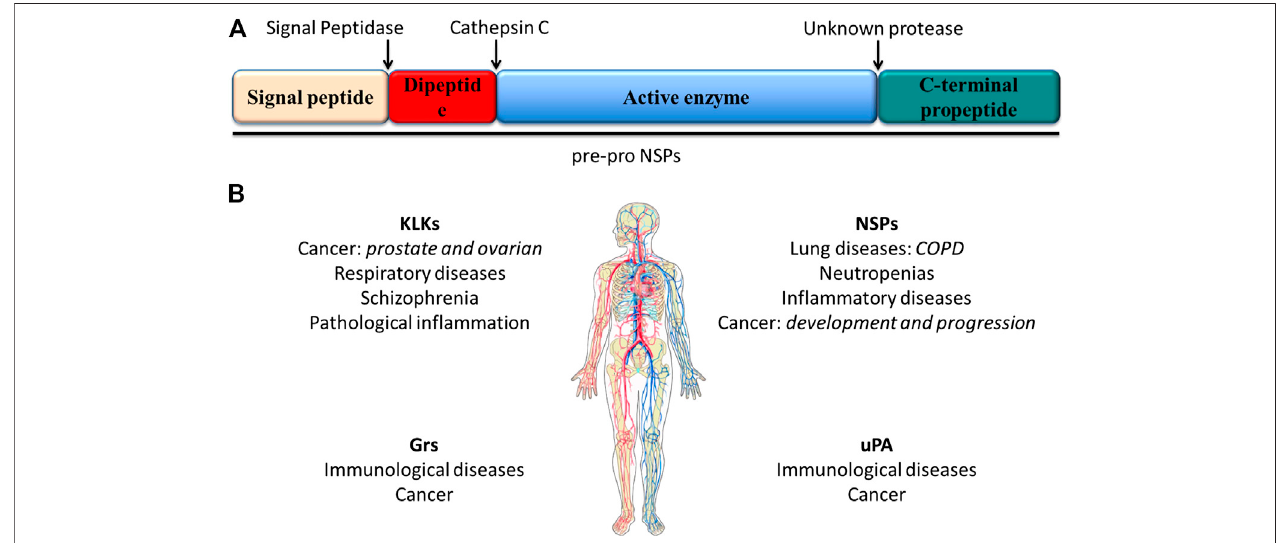
FIGURE 1 | (A) scheme of the structural features of preproproteases that form the NSP family. These enzymes are expressed as preproenzymes typically containing a signal peptide removed by signal peptidases, a dipeptide removed by cathepsin (C) , a protease sequence and a C-terminal propeptide removed by an unknown mechanism. (B) Serine proteases and associated diseases. Uncontrolled active serine protease activity can cause the excessive hydrolysis observed in some diseases including lung diseases and cancer (Korkmaz et al., 2008; Korkmaz et al.,